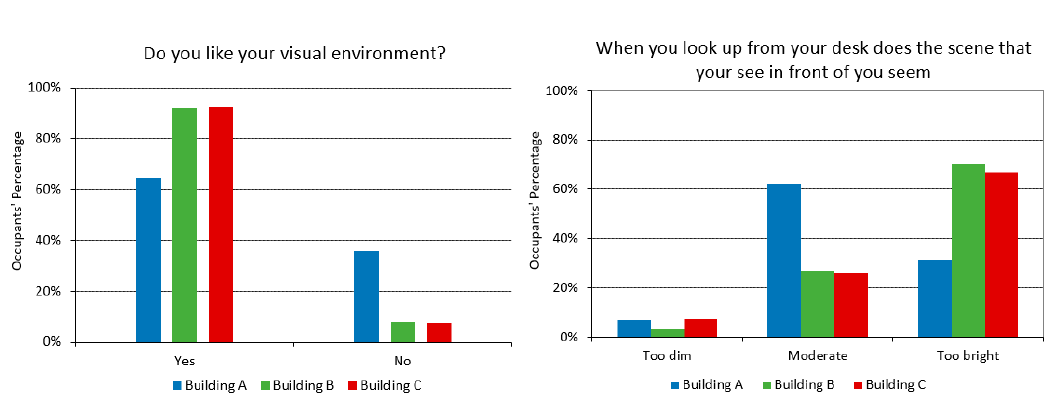
Figure 21. Occupants’ preference for their visual environment ( left ) and how dim or bright is the scene in front of them ( right ).